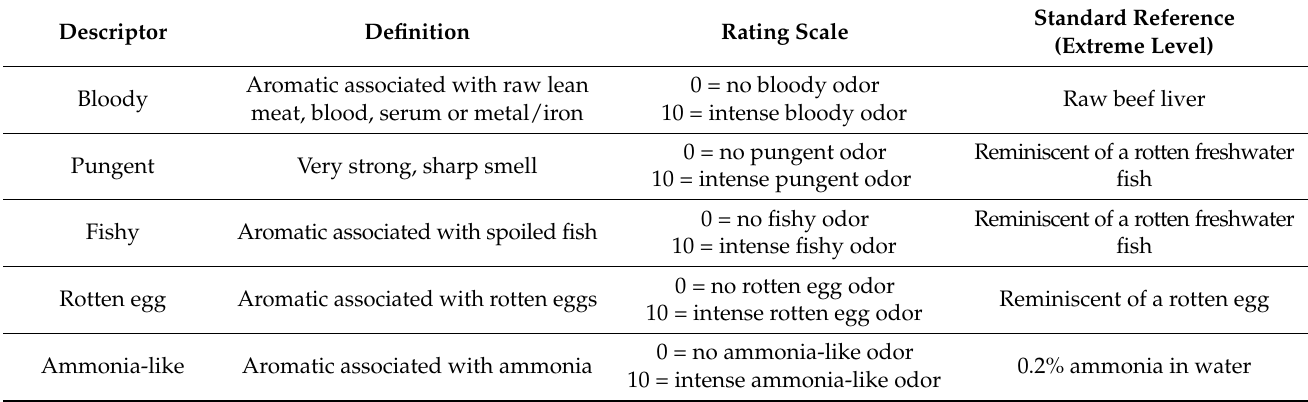
Table 1. Quantitative descriptive sensory analysis of the aroma of raw duck meat.